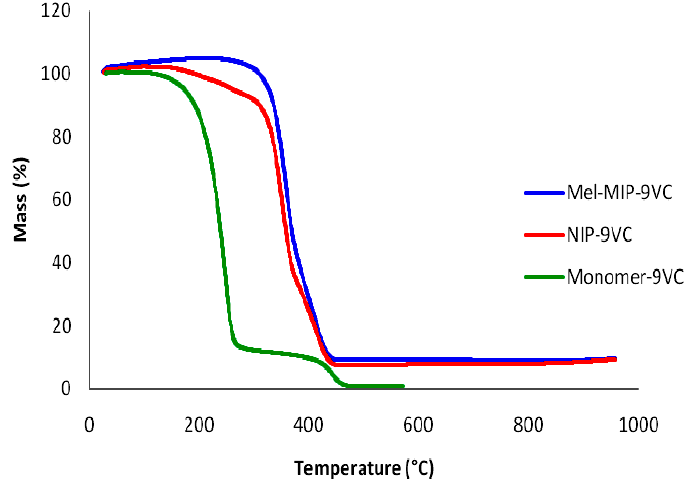
Figure 3. TGA curve for monomer-9VC, Mel-MIP-9VC and NIP-9VC.